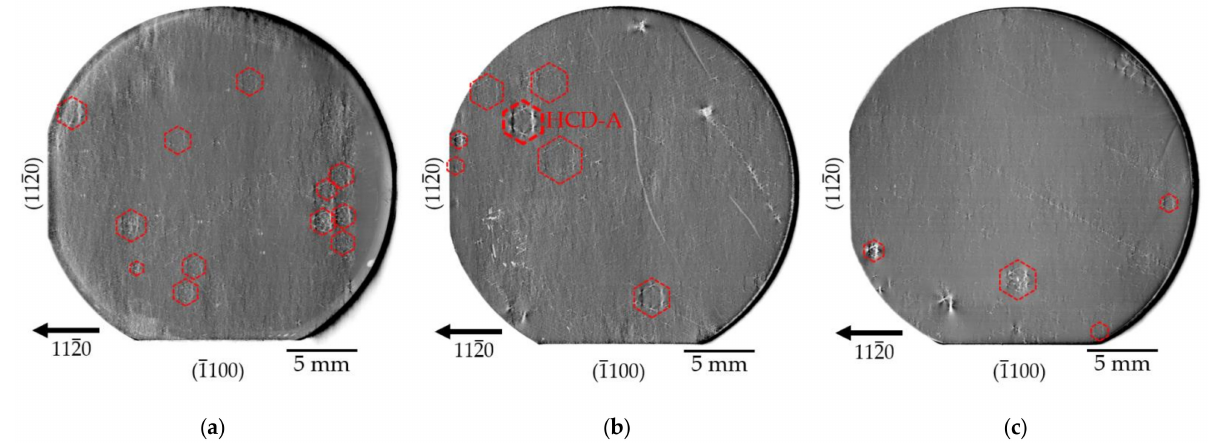
Figure 2. L-XRT 1120 reflection topopgraphs of three GaN substrates with HCDs (marked by red hexagons); ( a ) and ( b ) are topographs of semi-insulating Am-GaN substrates, while ( c ) is a topograph of an n-type Am-GaN substrate. The defect cluster denoted as HCD-A in Figure 2b is subject of detailed studies in the following and is, therefore,